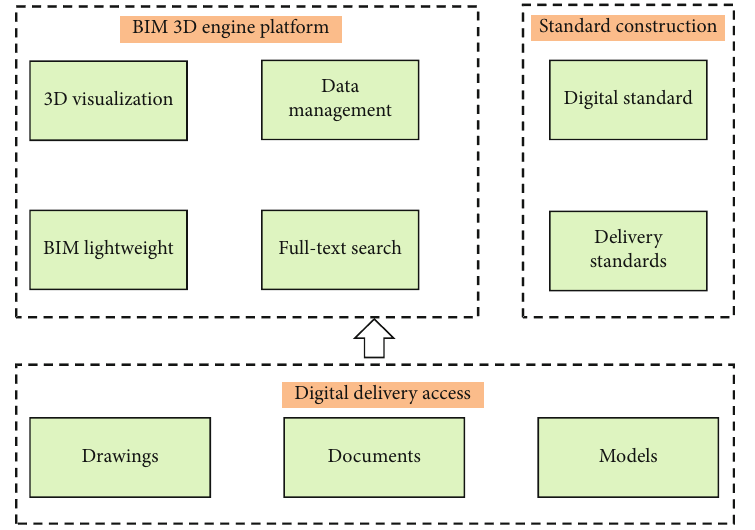
Figure 3: Application